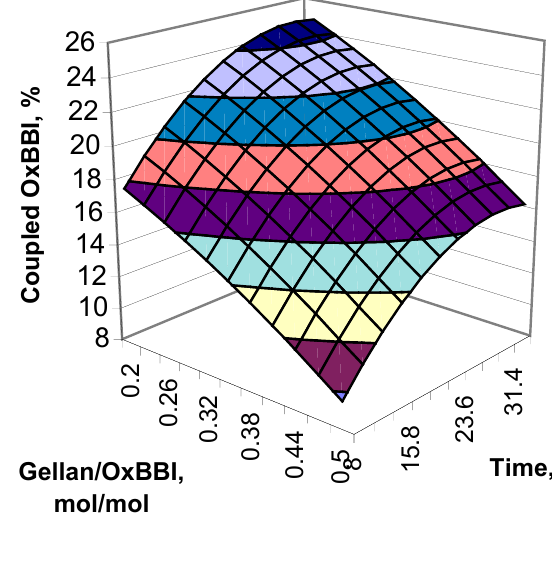
Figure 5. Influence of the gellan/OxBBI ratio and the reaction time on the amount of OxBBI bound in the coupling product, for a DCCI/OxBBI